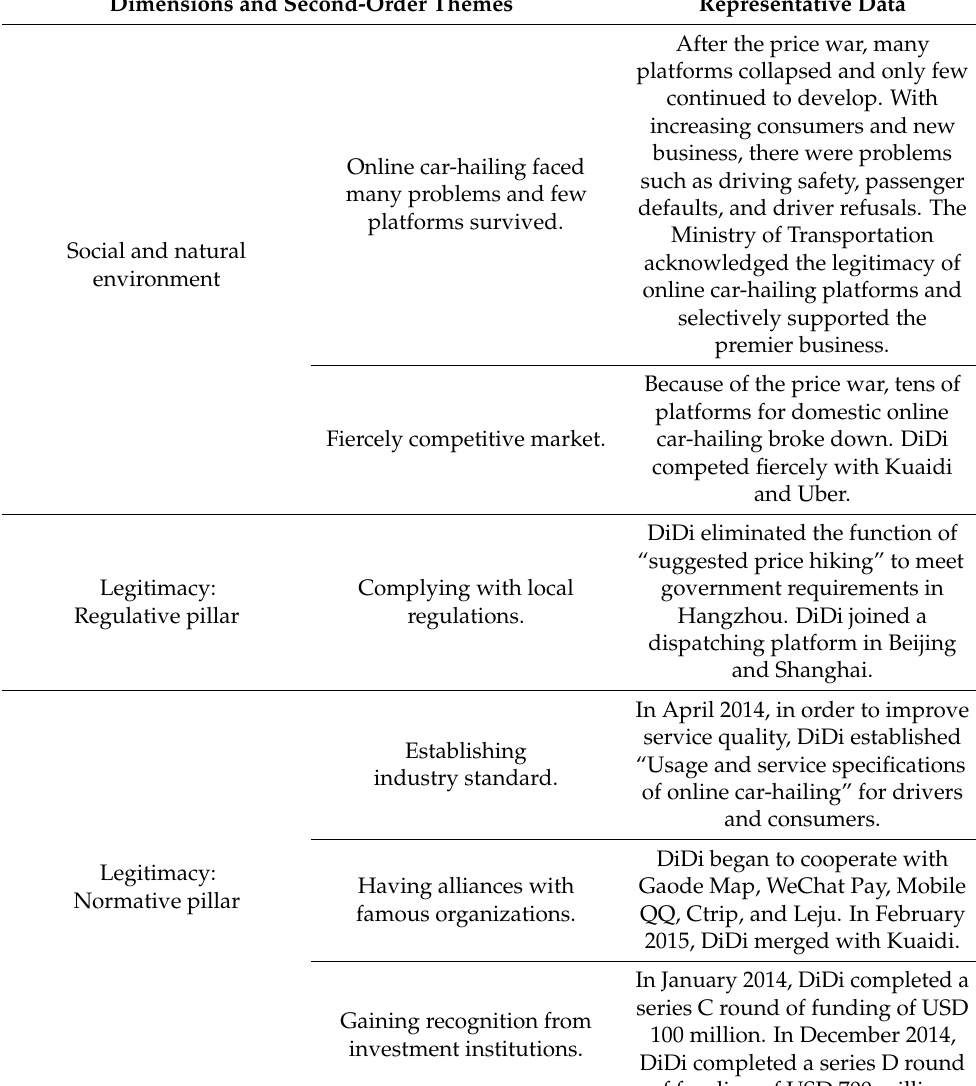
Table 4. Dimensions, themes and data in the phase of regulatory requirements for the premier